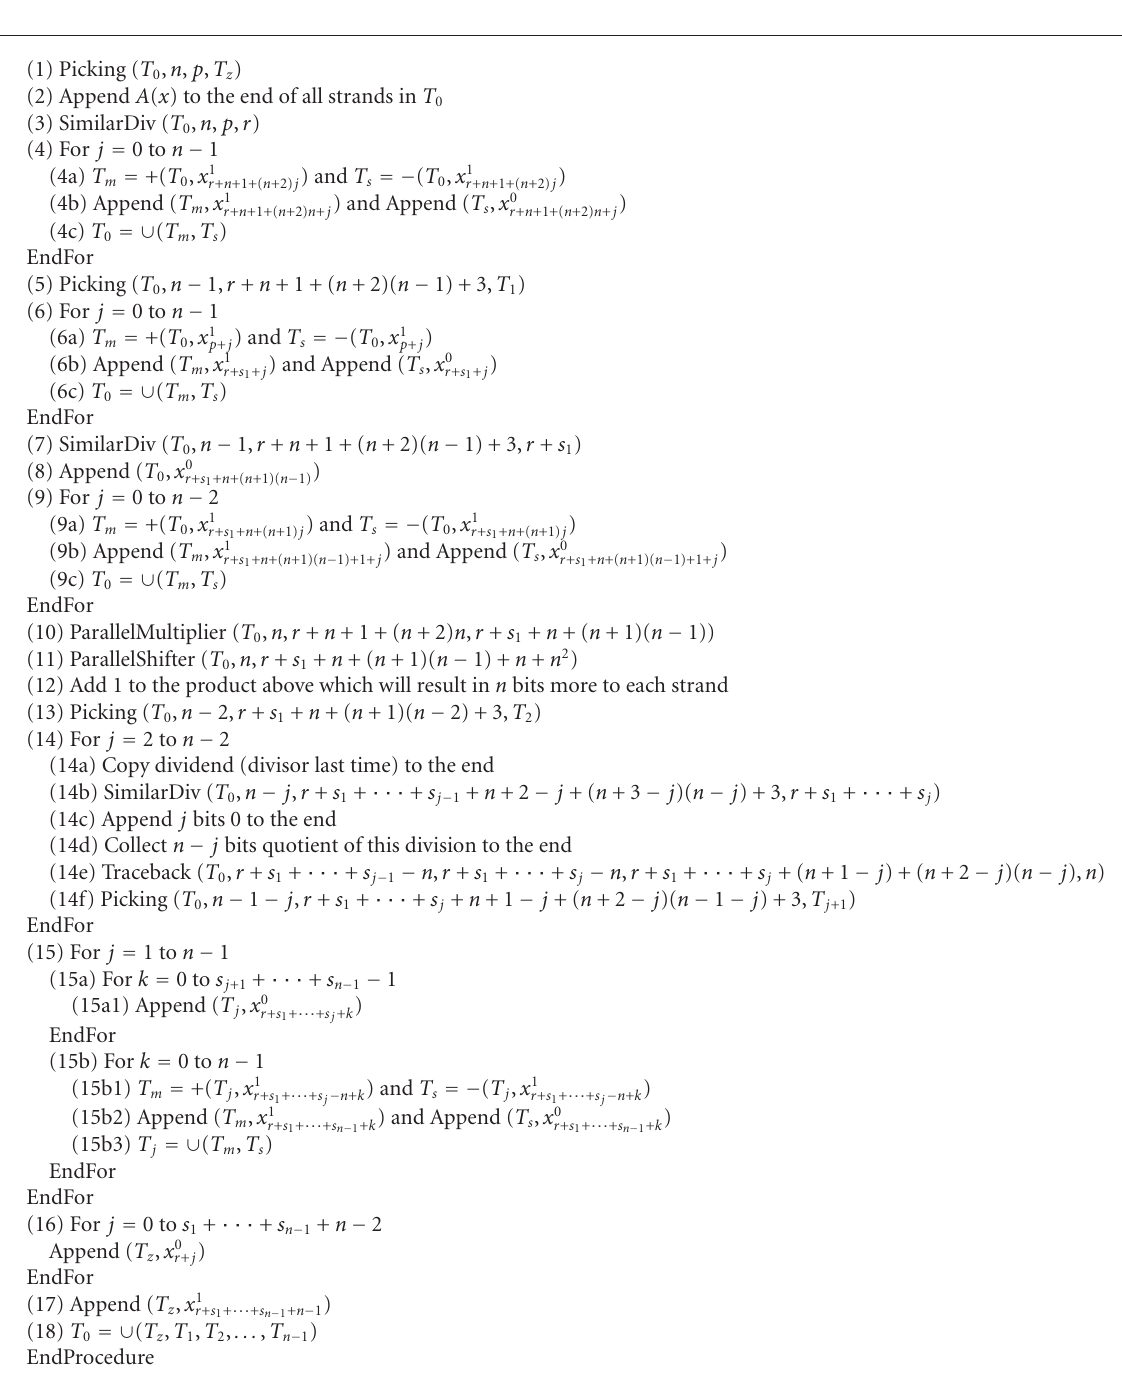
Algorithm 5: Procedure ParallelInverse ( T 0 , n , p , r